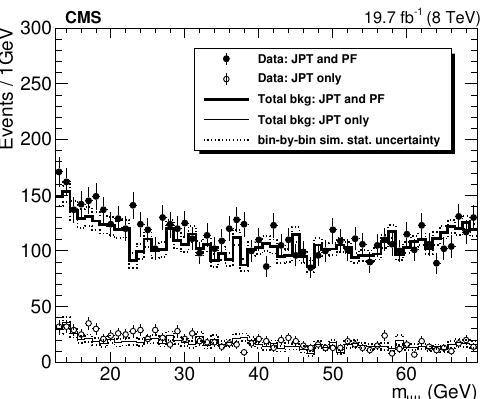
Figure 4 . The dimuon mass distribution with the pre-(cid:12)t expected background event yield for events selected by both the main (PF) and alternative (JPT) jet reconstruction methods as well as events selected by only the JPT